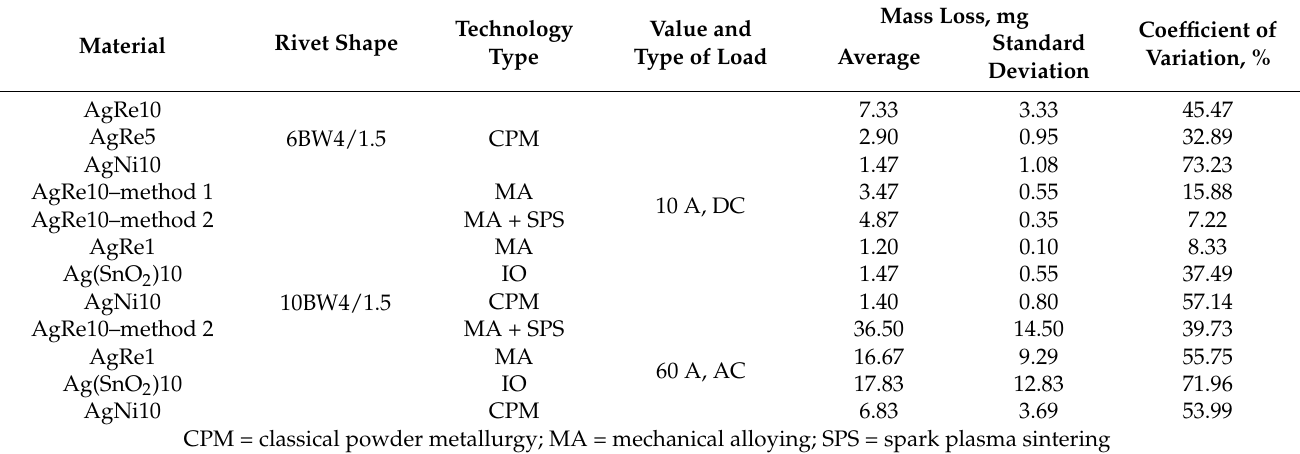
Table 5. Average and standard deviation and coefficient of variation of mass loss, number of switching: 50,000 for DC and 15,000 for AC.